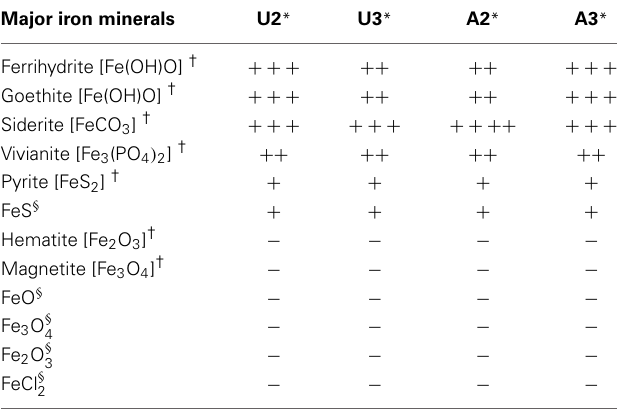
Table 3 | Qualitative and semi-quantitative analyses of major iron